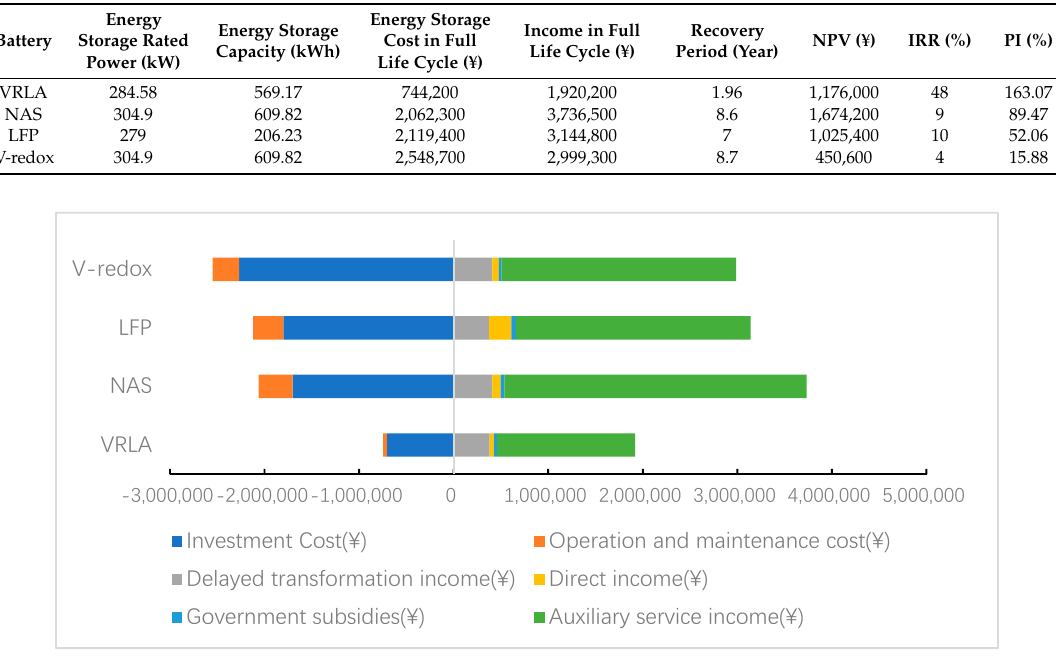
Figure 8. Each cost and income term of four different energy storage batteries for demand response. Energy Storage Charging and Discharging Results. The load power with the best battery selection is shown in Figure 9. The charge and discharge power of VRLA is shown in Figure 10. The battery discharges in the peak period to response the grid command. Due to the low electricity price, the battery charges in the valley period and flat